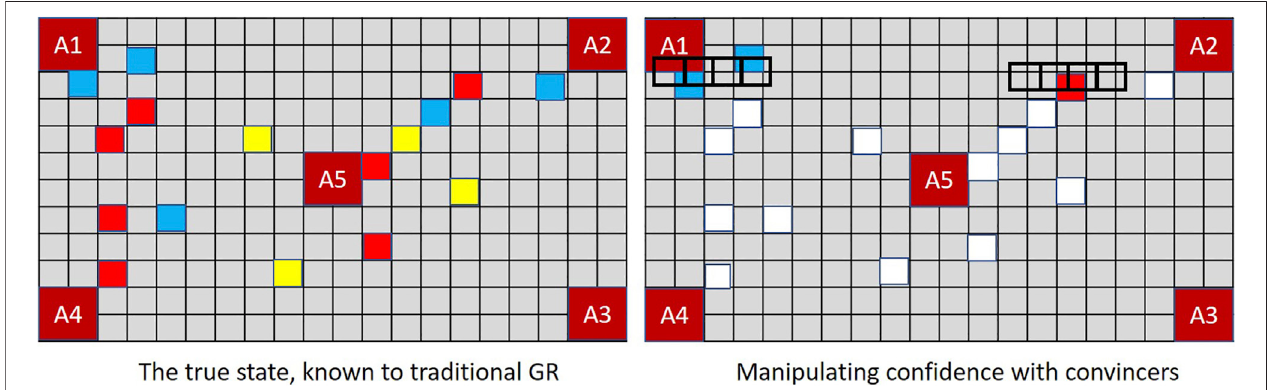
FIGURE 10 | In MindTrails, when an empty shuttle passes over a token its colour is momentarily revealed, reminding Player B of events that might otherwise be forgotten. Depending on their state of decay, these may be restored to their full magnitude or perceived as entirely new observations. A new positive observation at the previously suspected goal increases con fi